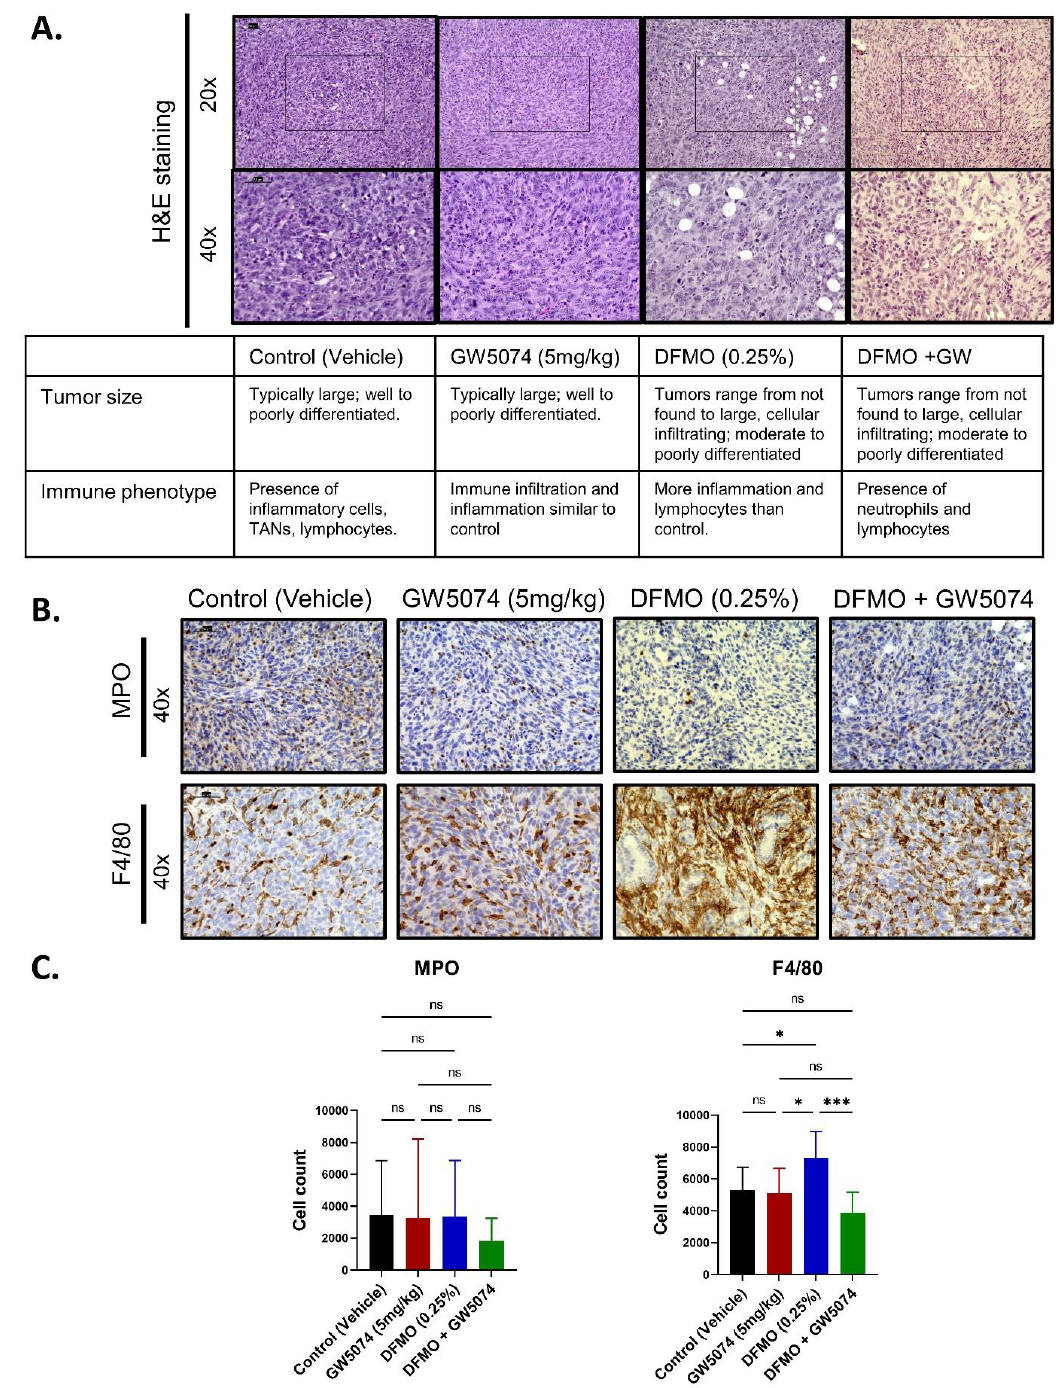
Figure 3. Histological assessment revealed cellular and molecular differences in DFMO-treated pancreatic tumors. ( A ) Tumor sections correspond to mice used for fixed-term studies in Figure 2A, right. These were PAN 02-injected mice treated after one week with control, GW5074 (5 mg/kg), DFMO (0.25% w / v ) and DFMO + GW5074 for a total of four weeks. Hemotoxylin and Eosin (H&E)-stained sections show changes in tumor phenotype and microenvironment, as depicted in the 20 × and 40 × images (40 × corresponds to the boxed regions in the 20 × images). Scale bars correspond to 50 µ m. Tabulated comments summarize broad cellular changes observed in each treatment group by histological assessment (TAN refers to tumor associated neutrophils). ( B ) Representative immunohistochemistry images of MPO and F4/80-stained DFMO-treated pancreatic tumor sections imaged at 40 × magnification. Scale bars correspond to 50 µ m. ( C ) Quantification of MPO and F4/80-positive cells across treatment groups. A one-way ANOVA followed by post hoc Tukey’s test for multiple comparison was used to analyze statistical significance between treatment groups ( p < 0.05 [*], p < 0.001